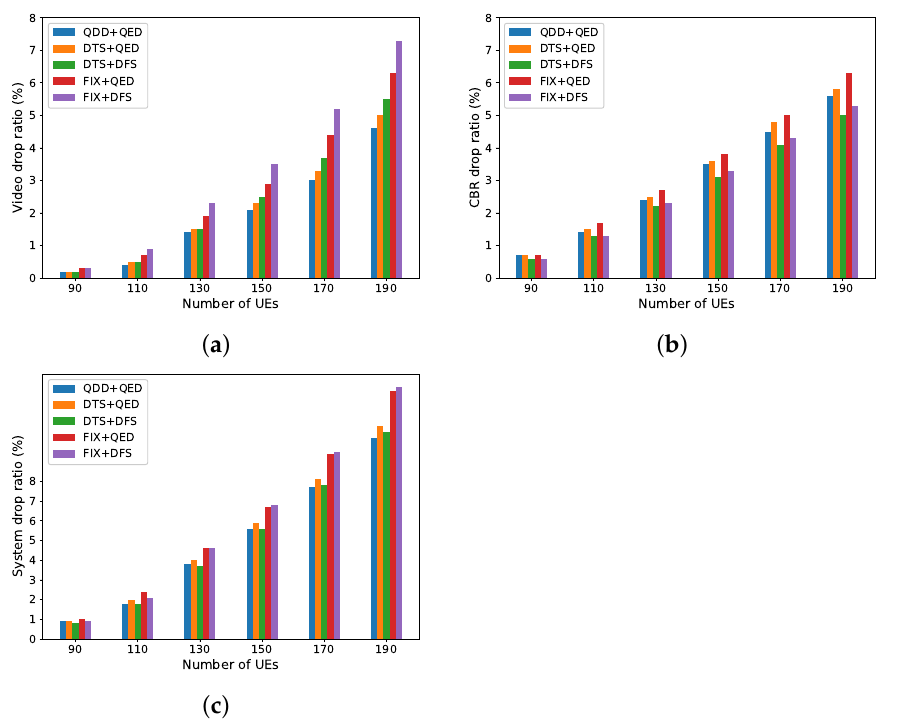
Figure 5. Simulation results on ( a ) video and ( b ) CBR ( c ) system packet drop ratios when varying number of UEs.